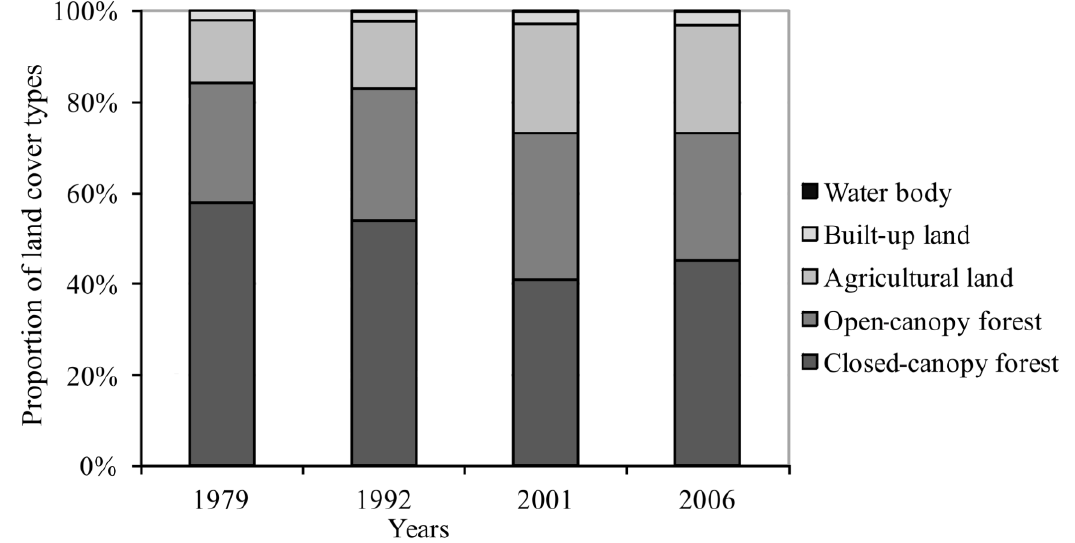
Figure 3. Land-cover categories in the years 1979, 1992, 2001 and 2006.